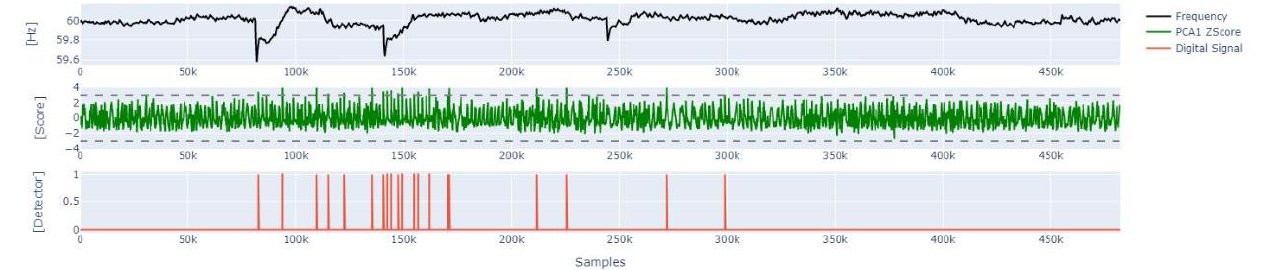
Figure 19. Event 2: detector event of PMU hydroelectric power station José Richa.